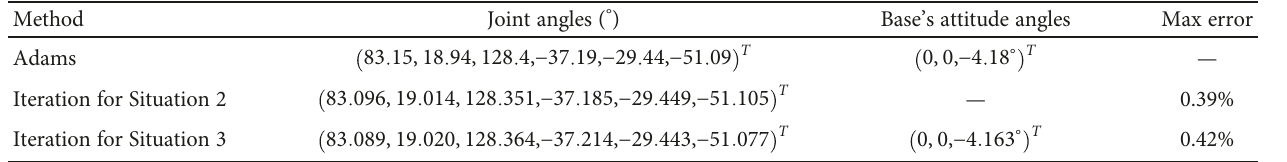
Table 1: Simulation results of the Adams simulation and the iterations for the planar model.